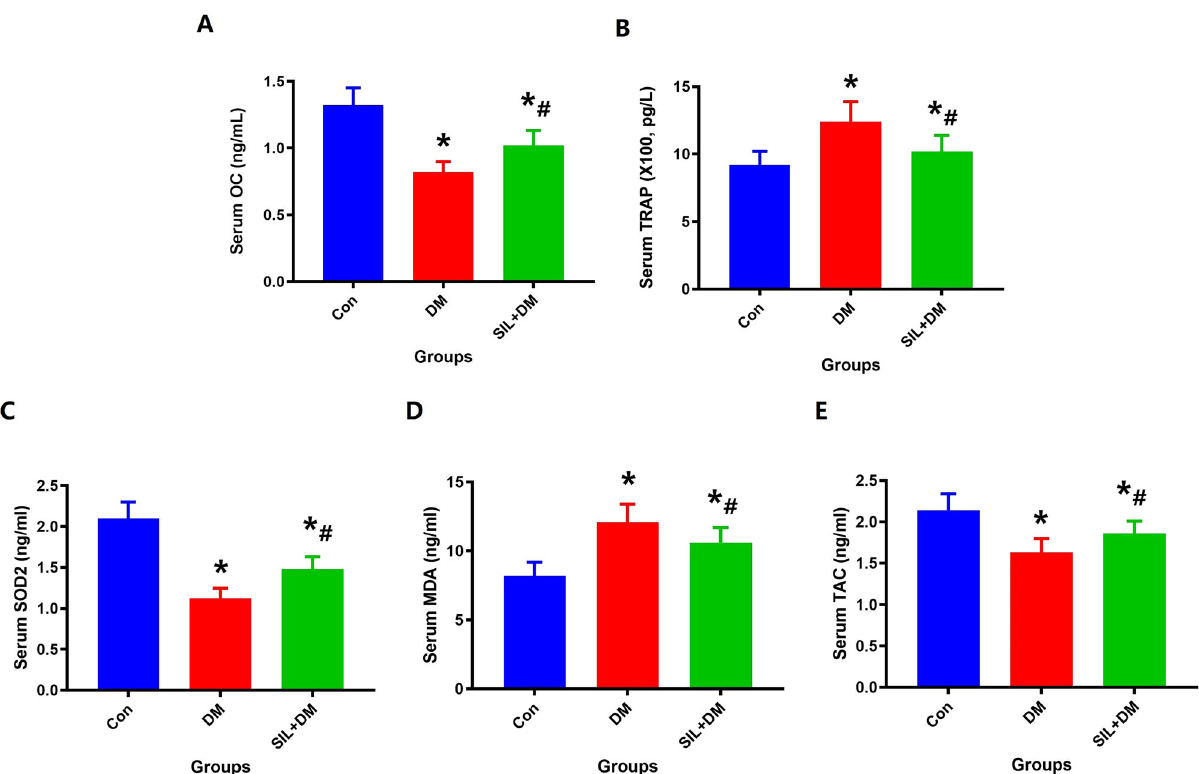
D : Serum MDA level; E : Serum TAC level; N = 5 specimens/group. *Vs. Con group, P < 0.05, #Vs. DM, P <